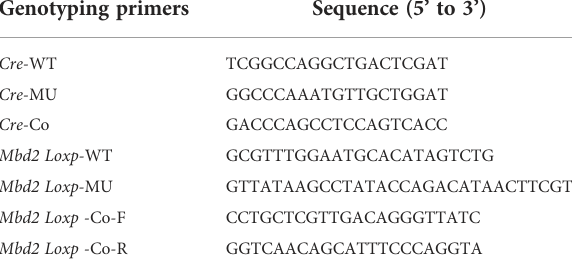
TABLE 2 Primer pairs used for genotyping for LyzM-Cre and Mbd2 Loxp/Loxp .